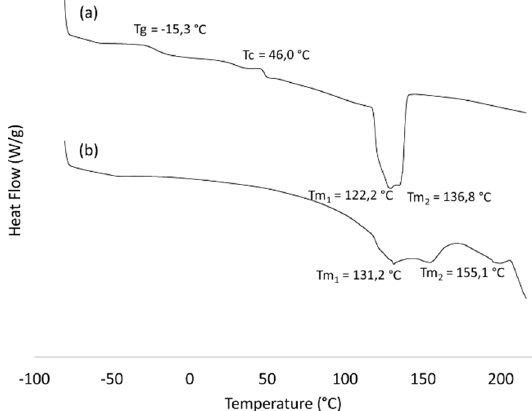
Figure 6. DSC thermograms of PHBHV-alkyne ( a ) and Pull- g -PHBHV ( b ). Polymers 2020 , 12 , x FOR PEER REVIEW